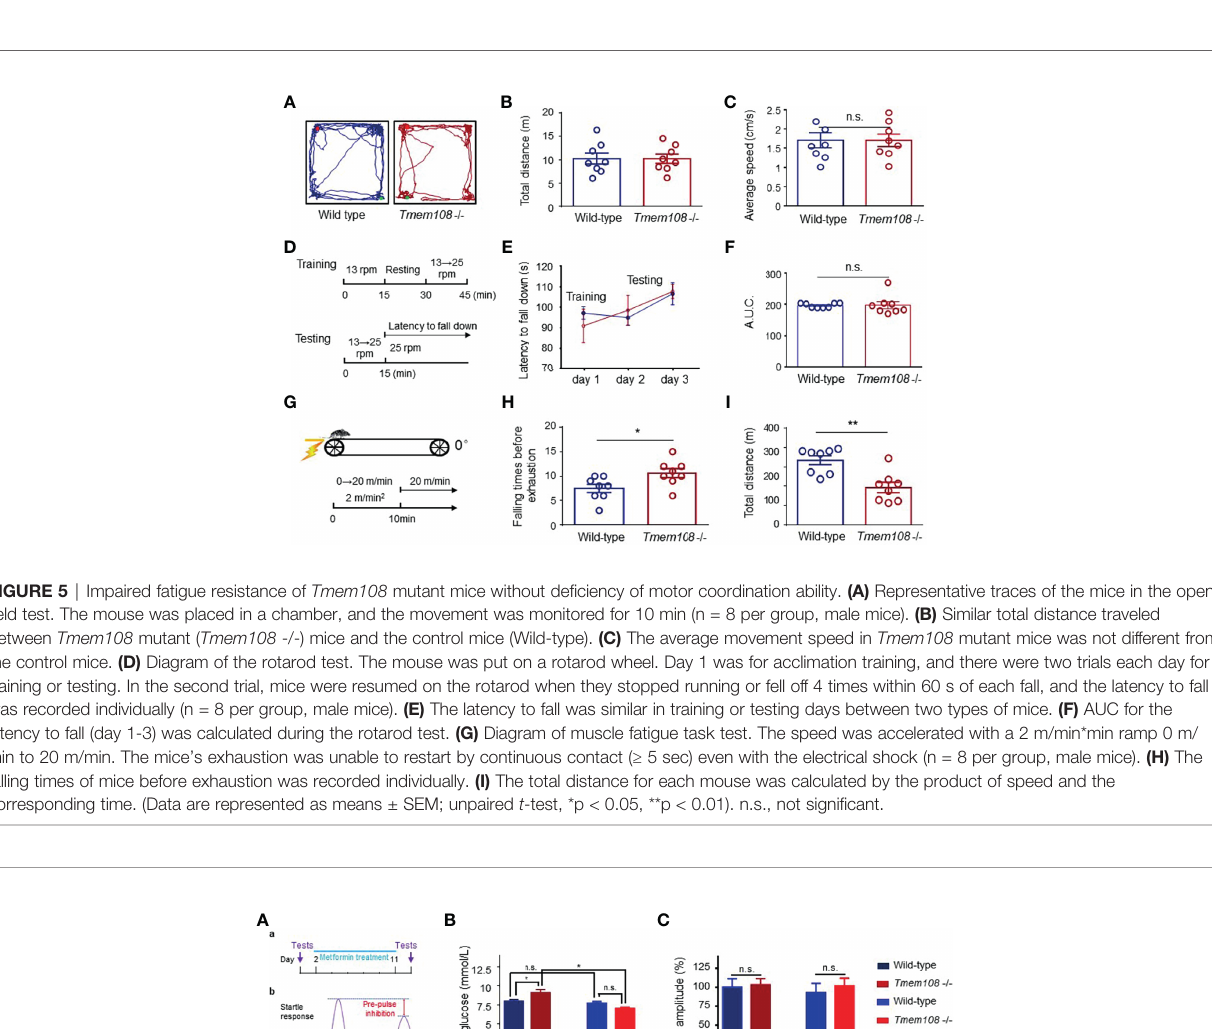
treatment, PPI decreased Tmem108 mutant mice were found only at pre-pulse 80 dB ( Figure 6E ). Therefore, metformin slightly enhanced startle responses of Tmem108 mutant mice and the enhancement was also found in the two-way ANOWA analysis, genotype variance variation from 0.001 (before metformin treatment, Figure 6D ) to 0.032 (after metformin treatment, Figure 6E ).